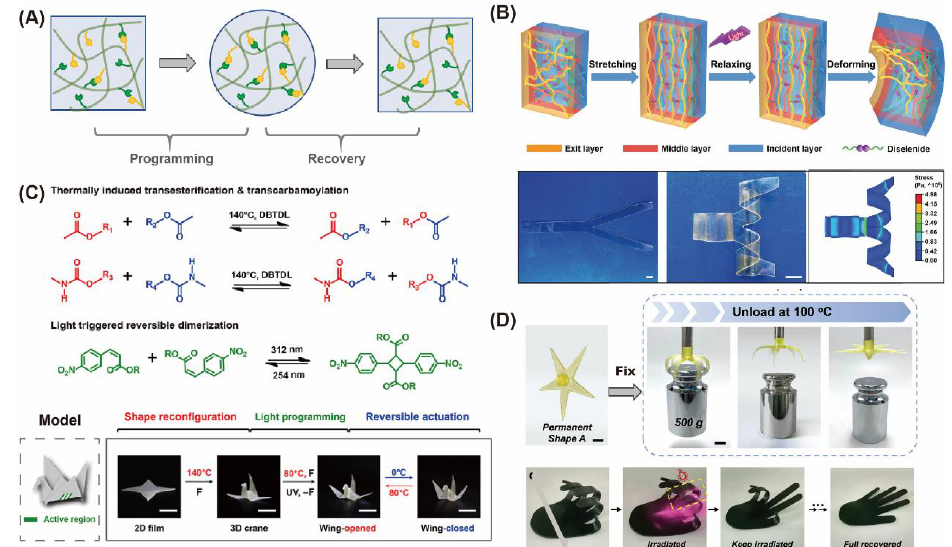
Figure 8. Shape memory dynamic covalent hydrogels. ( A ) shape memory process of dynamic covalent bond hydrogels; ( B ) shape programming through the light-induced dynamic diselenide exchange for tensile stress relaxation [149]. Copyright © 2021 Wiley-VCH GmbH; ( C ) thermally induced transesterification and transcarbamoylation and photo-reversible dimerization of nitro-cinnamate. Spatioselective reversible actuation in complex 3D objects [150]. Copyright © 2022 Wiley-VCH GmbH; ( D ) 4D printing polythiourethane (4DP-PTU) from dynamic thiocarbamate could be self-healing and remodeling [151]. Copyright © 2022 Wiley-VCH GmbH.